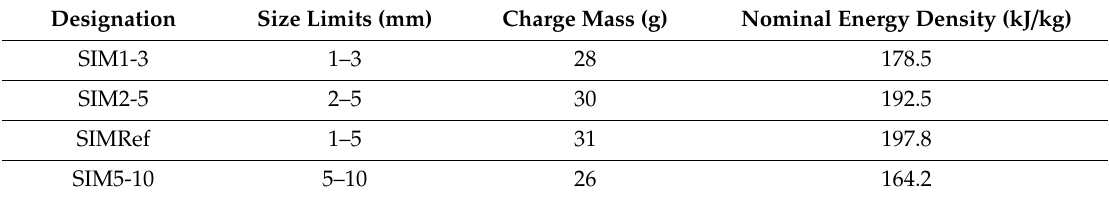
Table 1. Characteristics of the particle size when the reactor is filled with 20 mm of